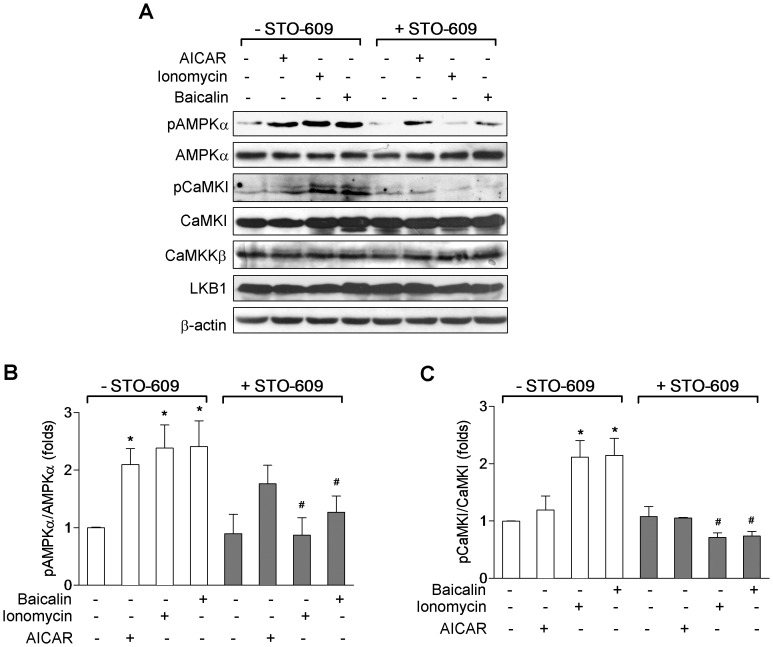
Effects of inhibition of CaMKKβ on baicalin-induced phosphorylation of AMPKα and phosphorylation of CaMKI in HepG2 cells.Cells were treated with 5 µM baicalin for 1 hr or 1 µM ionomycin for 5 min in control medium (open bars) or in the presence of 10 µg/mL of the CaMKKβ inhibitor STO-609 (solid bars). Representative Western blots for phosphorylation of AMPKα at Thr-172 (pAMPKα) and phosphorylation of CaMKI at Thr-177 (pCaMKI), and expression of total AMPKα, CaMKI, CaMKKβ and LKB1 (A). Histograms represent the fold change in the pAMPKα/AMPKα (B) or pCaMKI/CaMKI (C) ratio from at least three independent experiments. * p<0.05 compared to control; #
p<0.05 compared to respective treatment group in control medium. Representative Western blots are shown.